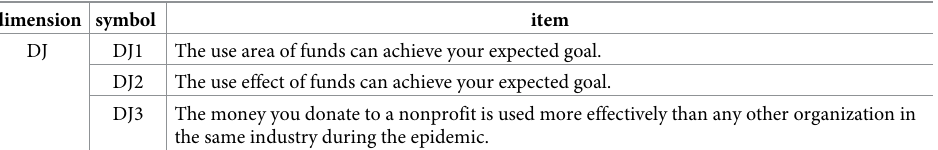
Table 3. Financial result fairness scale.